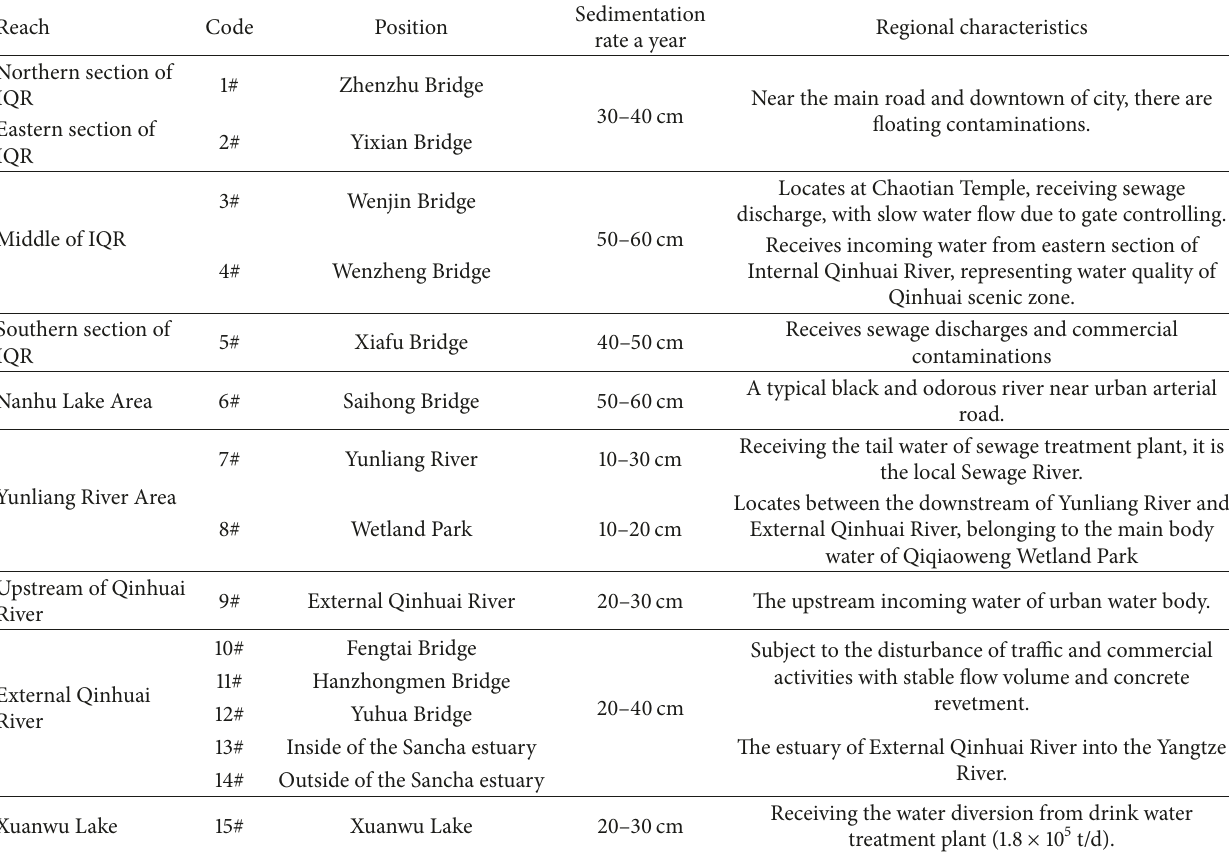
Table 1: Sampling sites and the corresponding regional